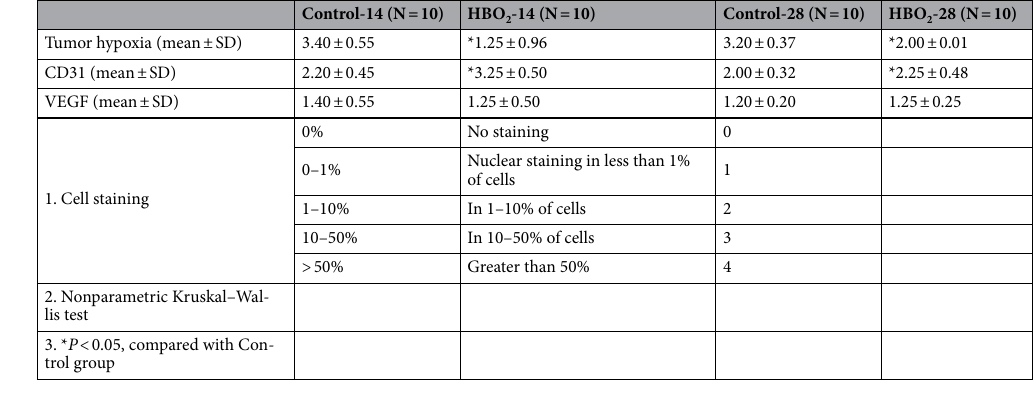
Table 1. Semi-quantitative expressions of tumor hypoxia, CD31 and VEGF in groups of mice after 14 and 28 days of HBOT.